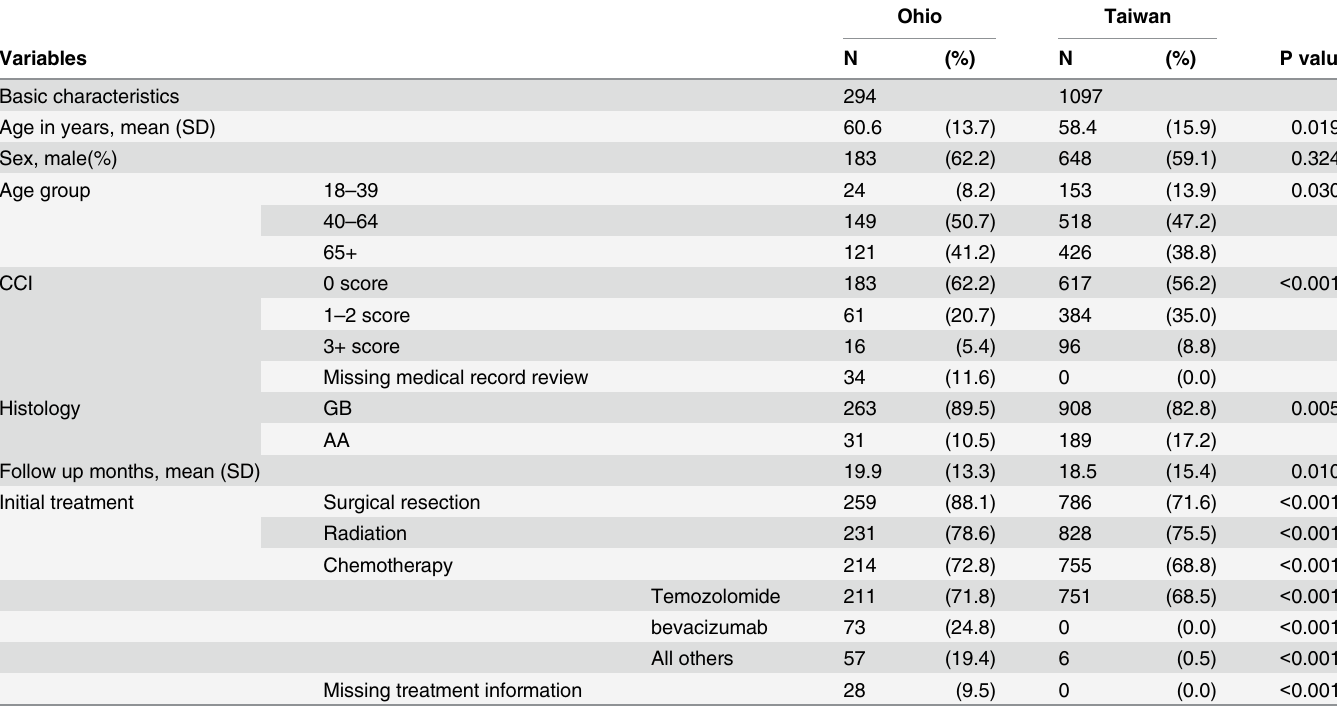
Table 1. Characteristics of Patients Diagnosed with the High Grade Glioma in Ohio and Taiwan.